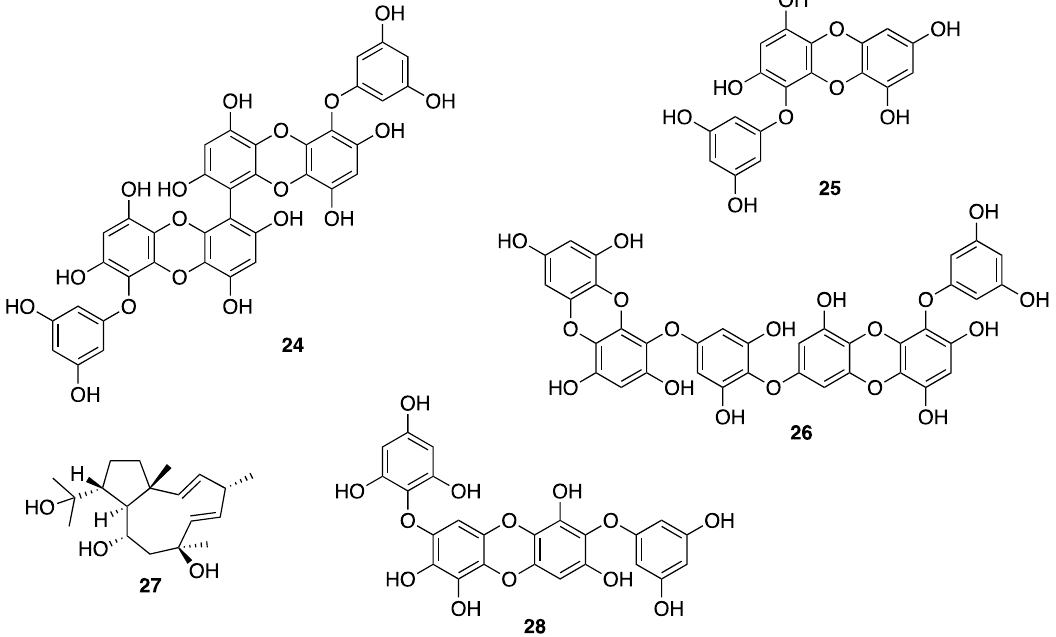
Figure 5. Structures of 6,6´-dieckol ( 24 ), eckol ( 25 ), dieckol ( 26 ), dolabelladienetriol ( 27 ), and diphlorethohydroxycarmalol ( 28 ).